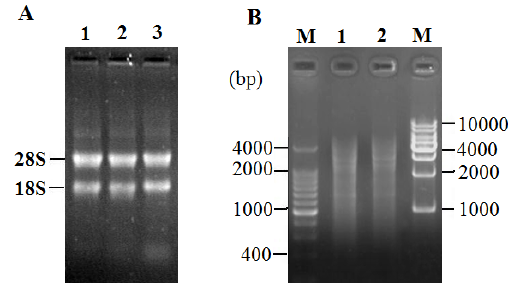
Figure 2. Total RNA from fibroblast cells of Bengal tiger and long distance PCR (LD-PCR). ( A ) Total RNA from fibroblast cells of Bengal tiger. Lane 1: a sample of 5 μ L total RNA; Lane 2, 3: two samples incubated at 37 °C for 2 h and 3 h, respectively; ( B ) The products of LD-PCR. M: marker; Lane 1, 2: the products of LD-PCR with 22 cycles.